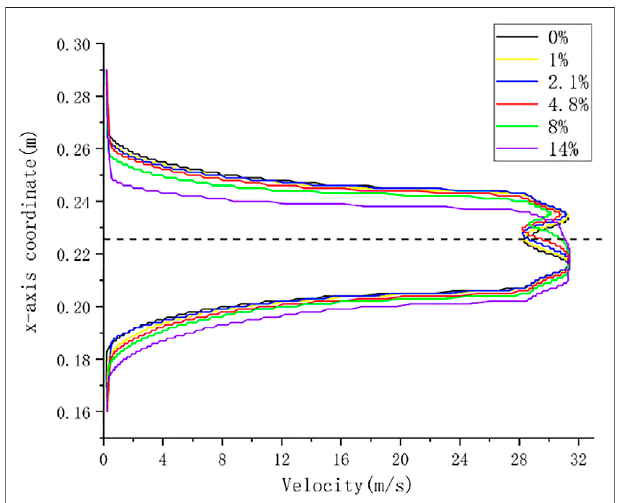
FIGURE 15 | Jet velocity on the straight line of z = 0 mm on the y = 30 mm